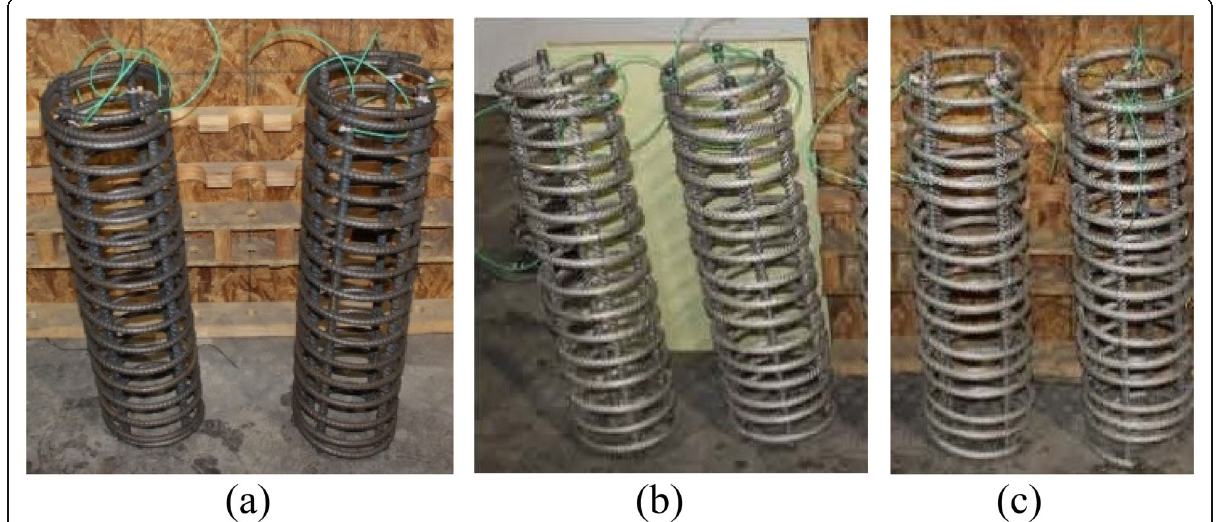
Fig. 2 Reinforcement of corroded specimens: a BB series; b CN series; c NN